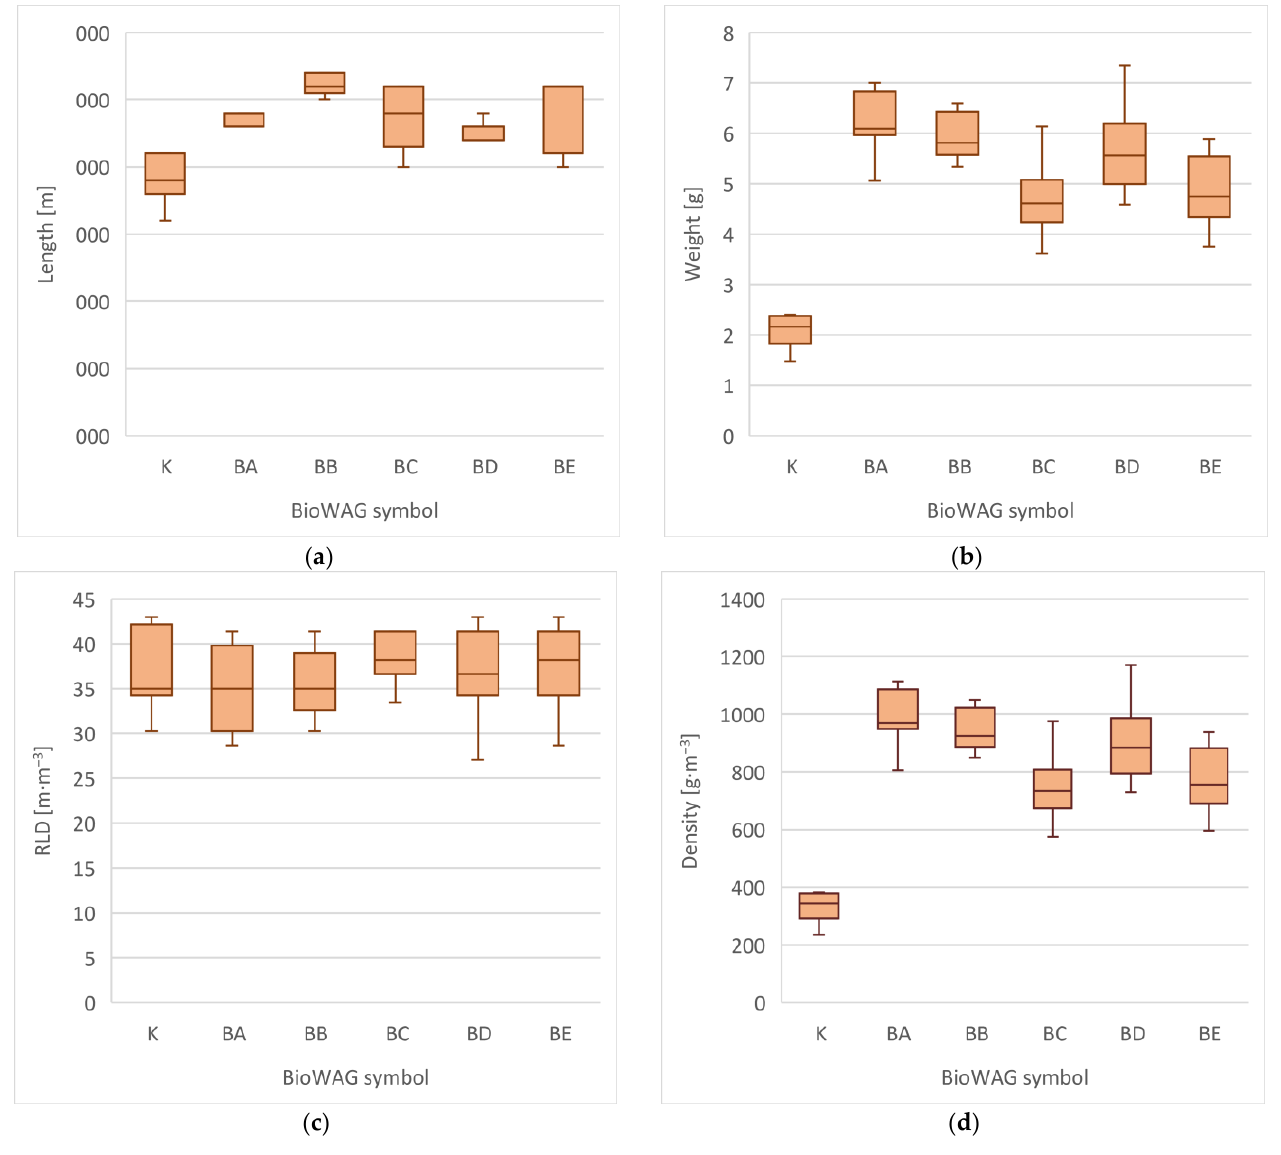
Figure 4. Biometric measurements of grass root system noted after the vegetation season (2018), depending on the type of BioWAG used: ( a ) length of the root system; ( b ) total weight of the root system; ( c ) values of the RLD index measured in reference to the total length of the root system; ( d ) total density of the root system. The diagrams show the first and third quartiles, medians, and minimum and maximum values.